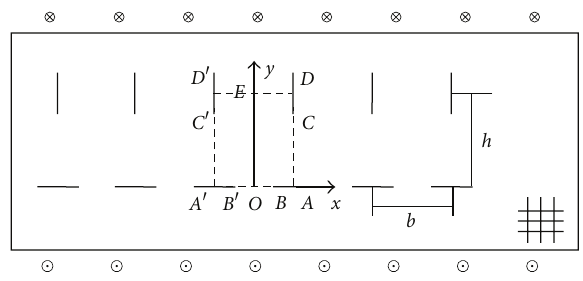
Figure 1: The crack model of doubly periodic cracks in the ortho- tropic composite plate.